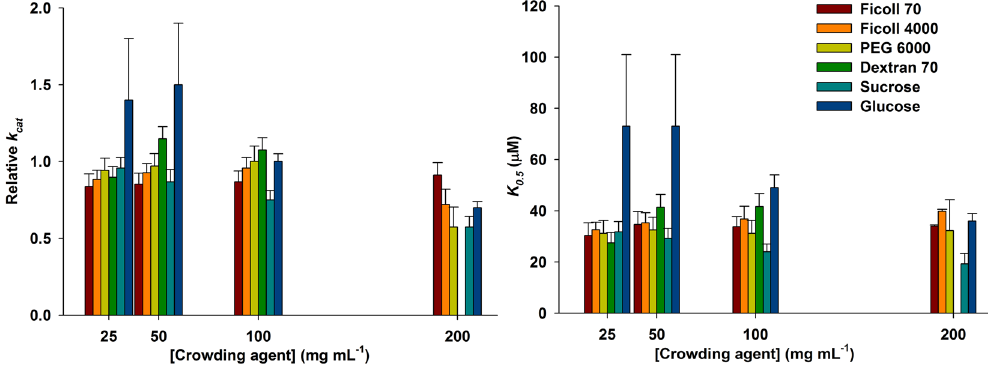
Figure 2. Relative apparent kinetic parameters determined for DD-CoA substrate. ( A ) K 0.5 values obtained for DD-CoA substrate in the presence of crowding agents; ( B ) relative k cat values obtained for DD-CoA substrate in the presence of crowding agents. Error values are also given in Table ST1.